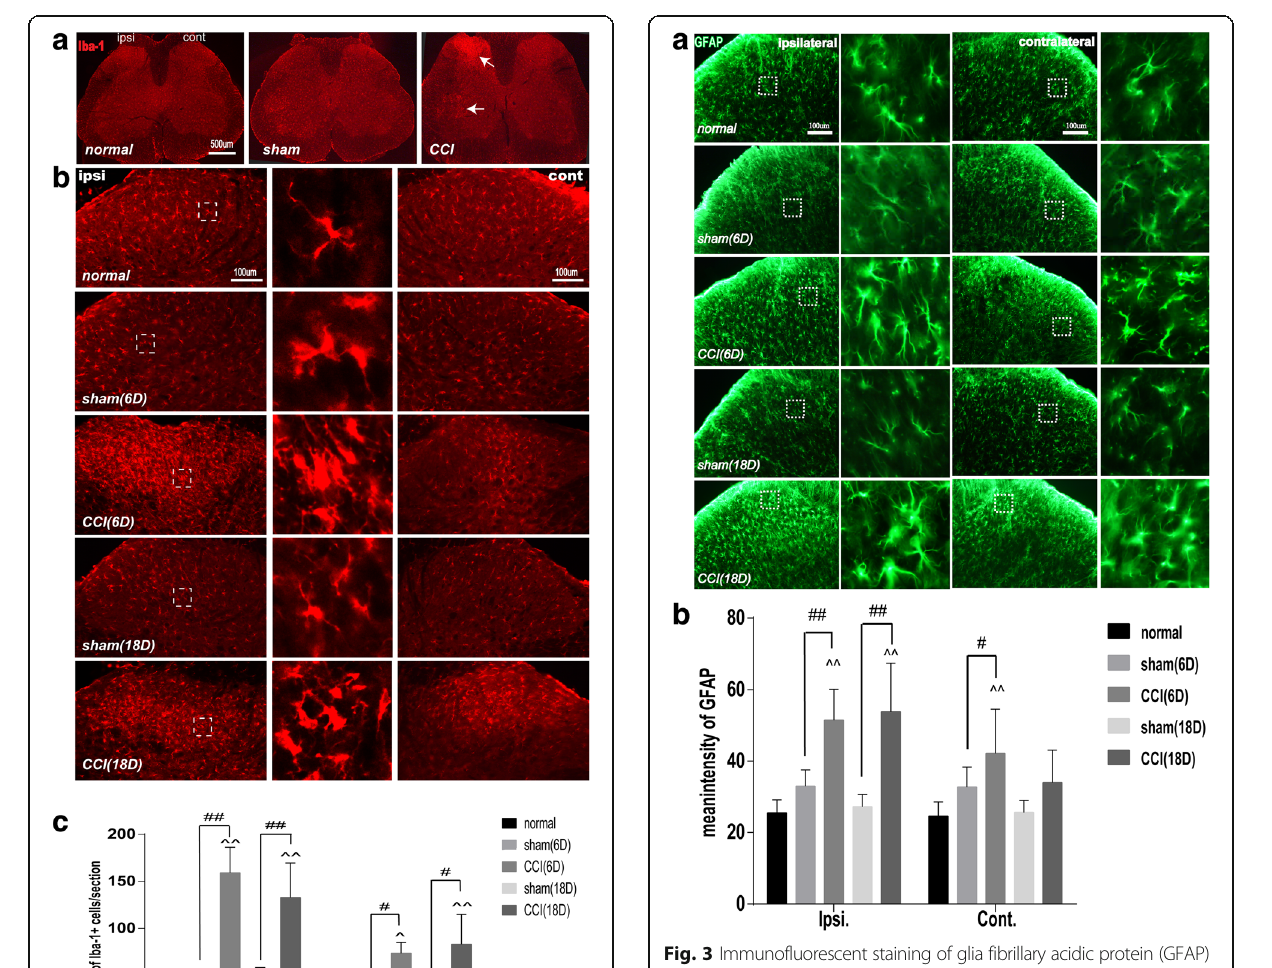
Fig. 3 Immunofluorescent staining of glia fibrillary acidic protein (GFAP) for displaying astrocytes in Ipsi and Cont DHs of lumbar spinal cord on day 6 and 18 after CCI in rats of the five groups. a Representative samples of immunofluorescence staining showing an increase of the number of GFAP-labeled astrocytes in the superficial layers of DHs of lumbar spinal cord on the Ipsi and Cont sides of surgery on day 18 (relevant to day 6). In the right column of both Ipsi and Cont DH section samples, a magnification of GFAP-labeled astrocytes (got from the dashed square boxes of the tissue section samples on the left side) is shown, suggesting an increase of number of the activated astrocytes after CCI. b Bar graphs showing the mean immunofluorescence intensity of GFAP in the Ipsi and Cont DHs on day 6 and 18 in the 5 groups. Eight rats in each group were examined and data are expressed in Mean± SD(n=6/group). ^^ P<0.01, vs the normal group; # P<0.05, ## P <0.01, vs the sham